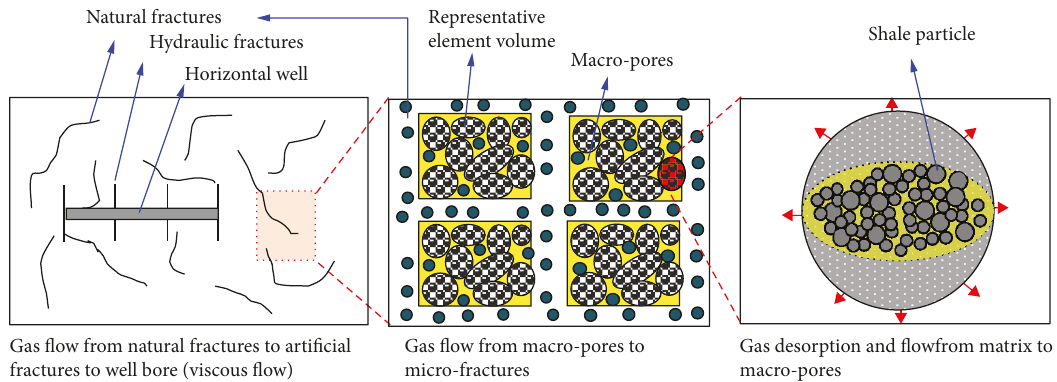
Figure 6: Diagram of matrix desorbed gas fl ow through macropores to